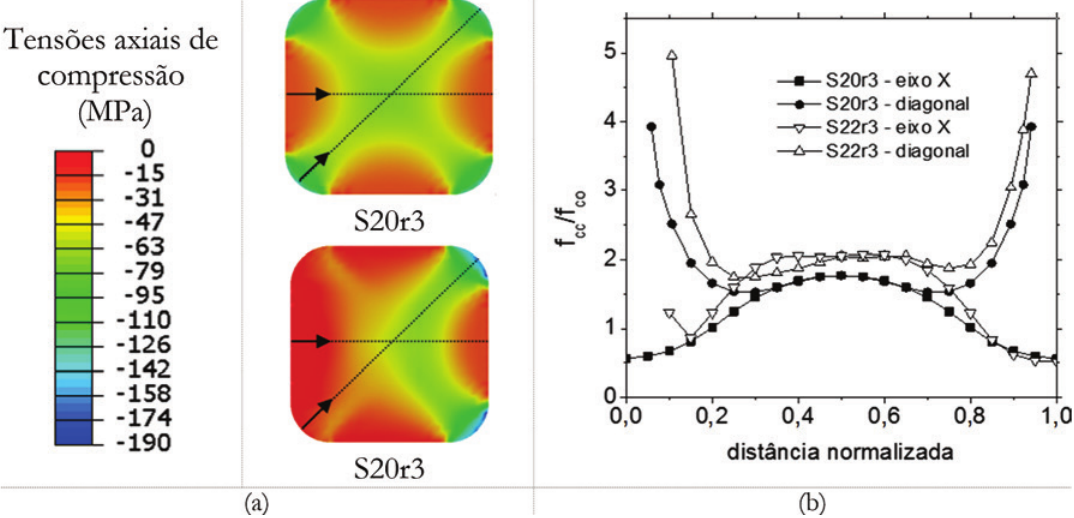
Figura 12 Tensões de compressão em pilares quadrados S20r3 e S20r3 (valores em MPa): (a) distribuição de tensões; (b) acréscimo de tensões nos trechos indicados em (a)